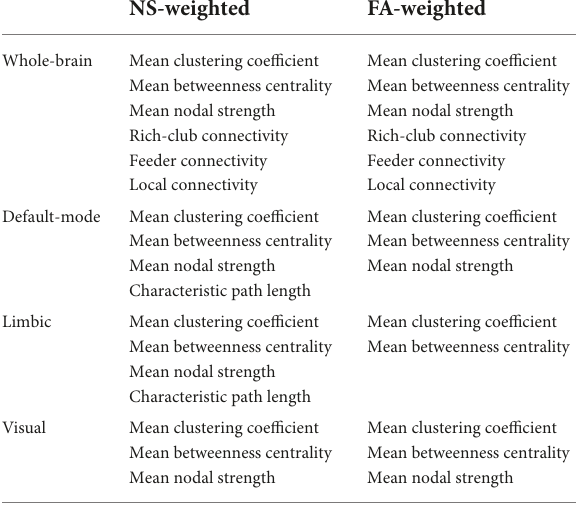
TABLE 3 Metrics used in the analysis for each